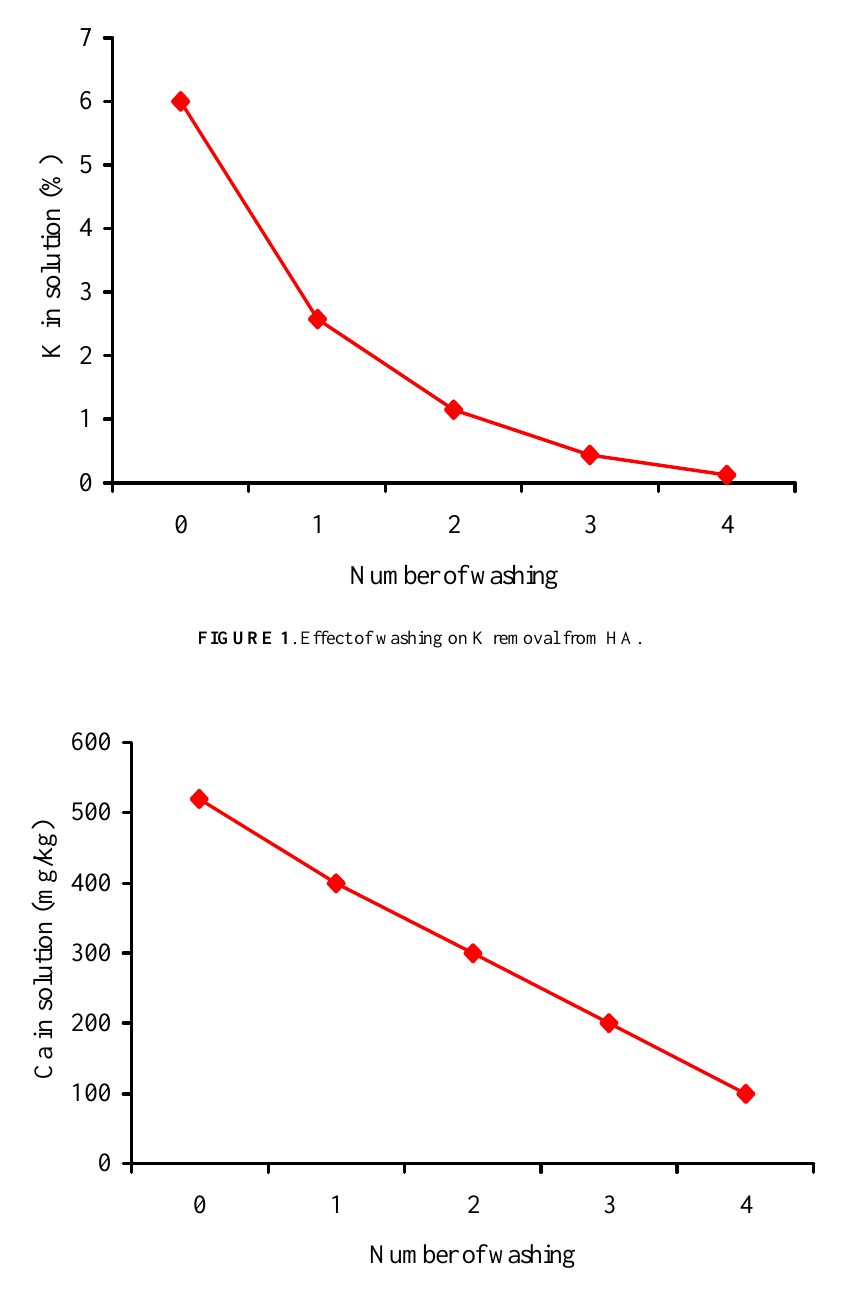
FIGURE 2 . Effect of washing on Ca removal from